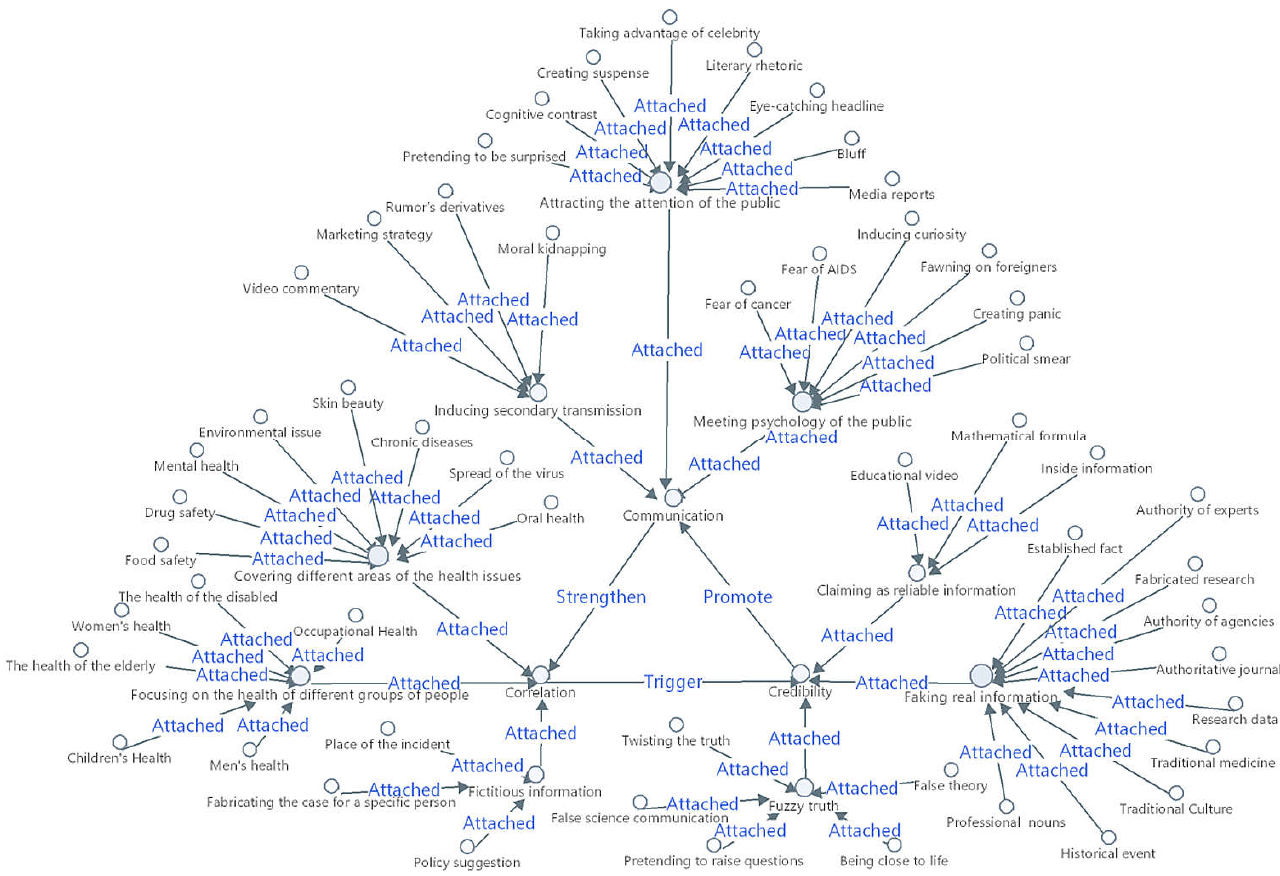
Figure 2. Internal dynamic mutual assistance mechanism (relationship among Correlation, Credibility, and Communication).